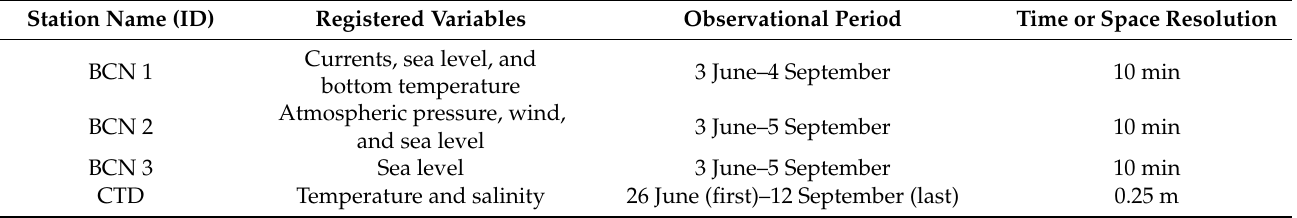
Table 2. Summary of data measured at the stations shown in Figure 1, corresponding to the Barcelona harbour campaigns, indicating observation periods and data recording